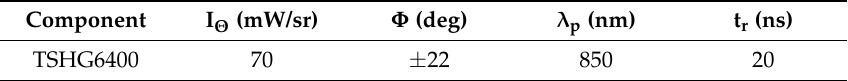
Table 3. Summarised technical specifications of the IR-LED.